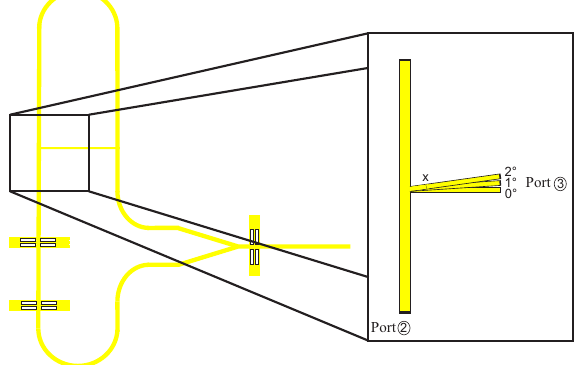
Figure 11. Enlarged illustration of the transition from the dielectric waveguide to the support structure with three different angles of inclination.